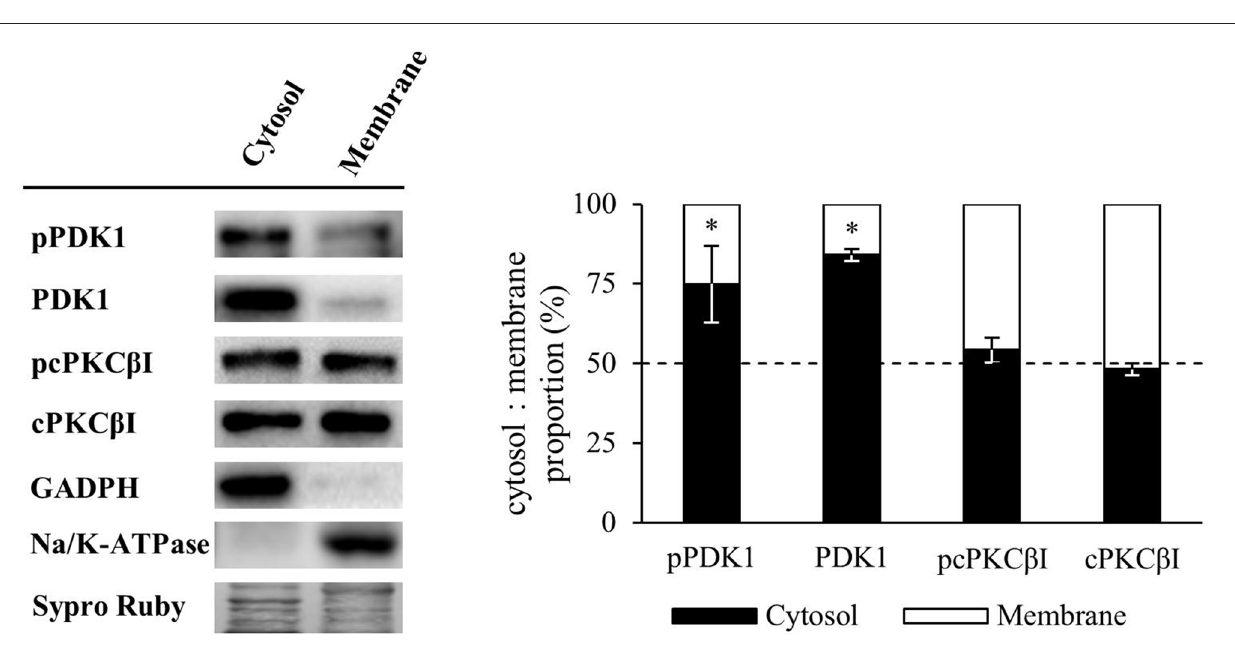
cPKCs quantitatively autophosphorylated at their turn-motif and hydrophobic loop. Therefore, to avoid the interference of dephosphorylation, we analyzed the phosphorylation of cPKC β I with an antibody against Thr642 turn-motif phosphorylation, which is the subsequent phosphorylation induced by PDK1 and it is required for kinase activity (Zhang et al.,